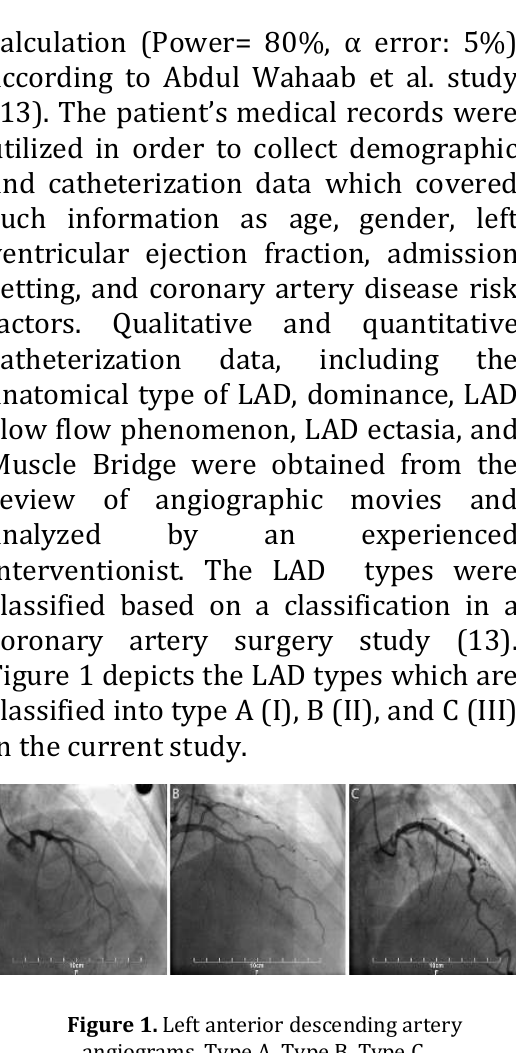
Figure 1. Left anterior descending artery angiograms. Type A. Type B. Type